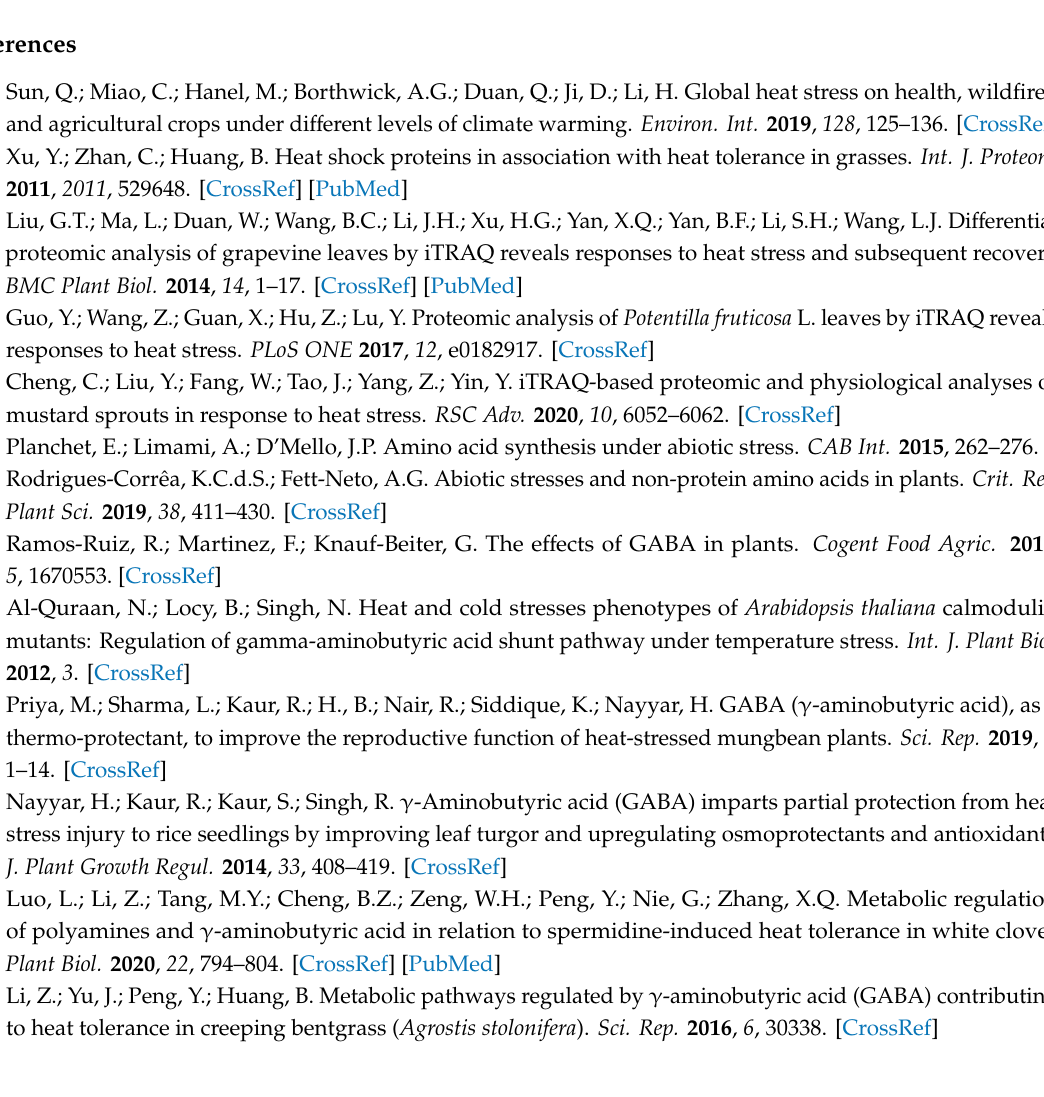
Supplementary Materials: The following are available online, Table S1: Basic information of key di ff erential expressed proteins (DEPs) in HSG vs. HS based on the analysis of interaction